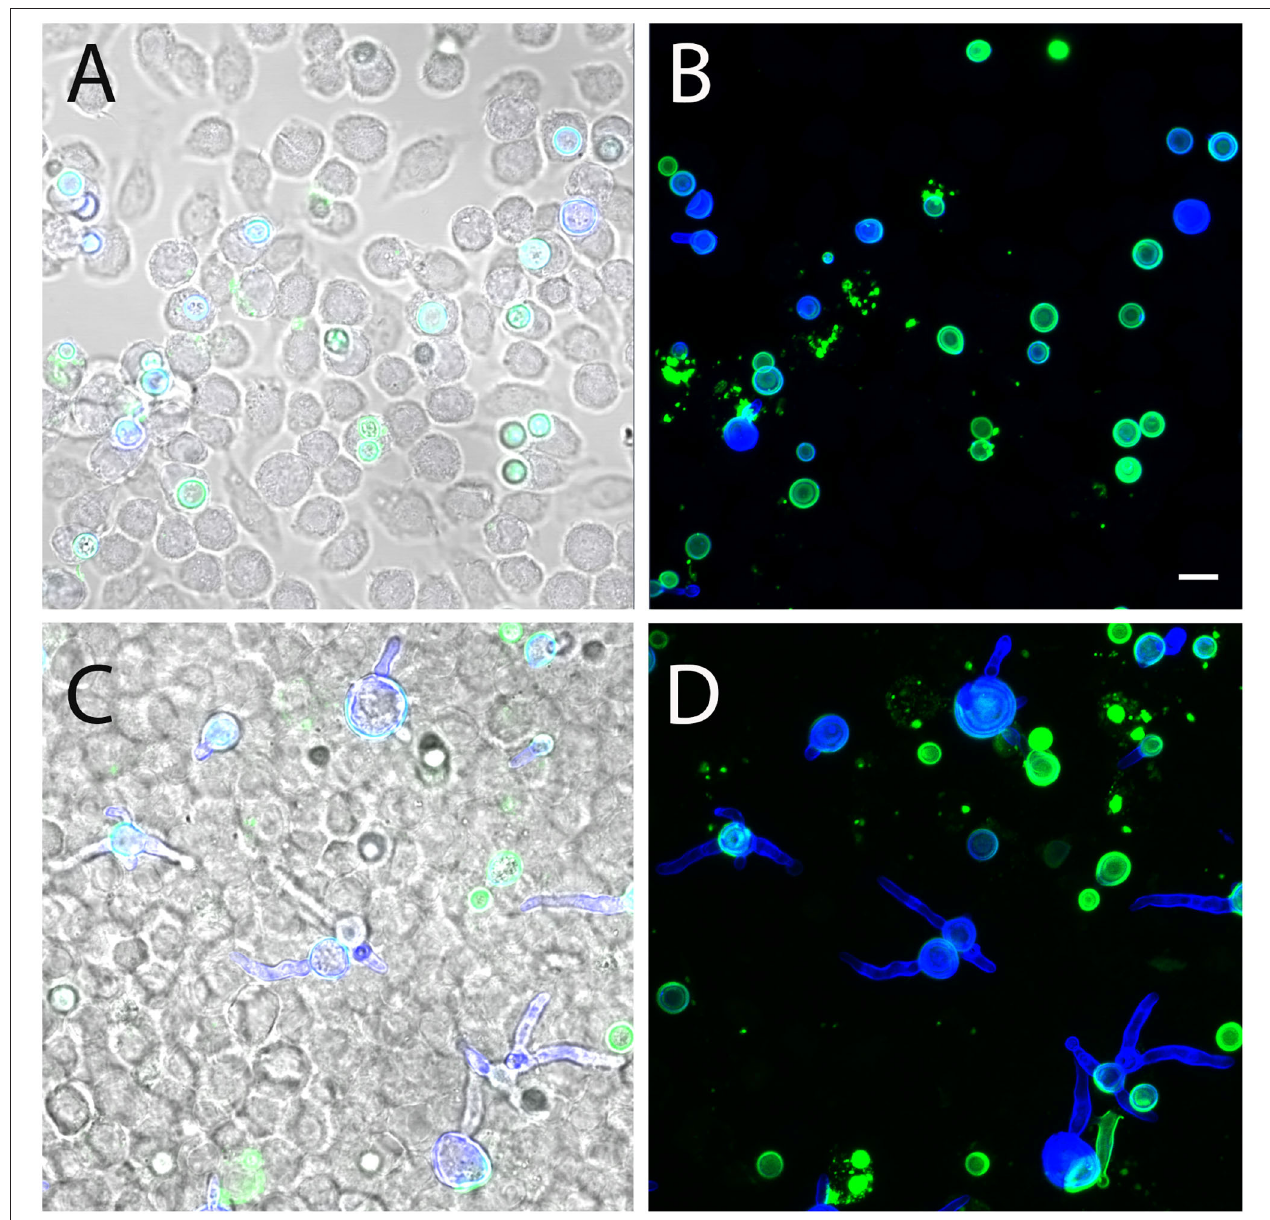
FIGURE 12 | Germination of AC within J774 macrophages. Macrophages were infected with FITC-labeled AC. Samples were fixed after 6h (A,B) and 24h (C,D) and stained with Calcofluor white (blue). (A,C) show single optical planes and overlays of the green and blue fluorescence as well as the corresponding brightfield image. (B,D) show maximum projects of the green and the blue channel. The bar in (B) represents 5 µ m and is valid for all panels.